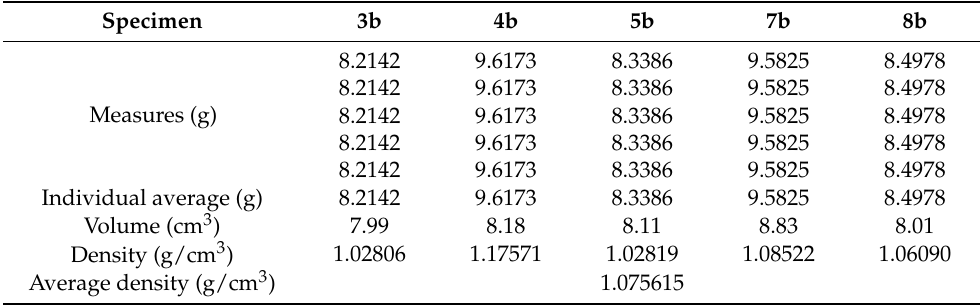
Table 5. Result table of average density values.